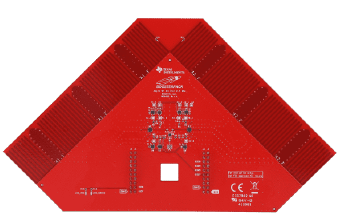
Figure 2 . SimpleLink™ multi-standard CC26x2R wireless MCU LaunchPad™.